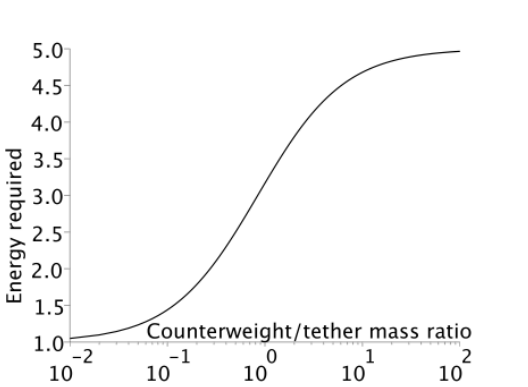
Figure 7. The energy (normalized) spent to spin-up a tether with a point-mass counterweight on one end, from standstill to fixed free tip